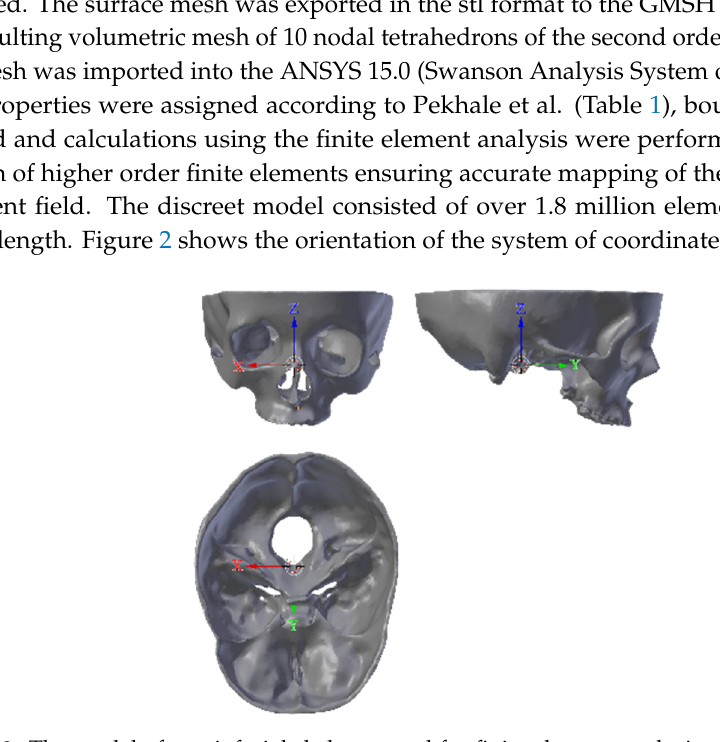
Figure 2. The model of craniofacial skeleton used for finite element analysis and orientation of the system of coordinates on the model. The foramen magnum, which formed the base of the model, was constrained in its displacement by the X, Y, and Z direction.